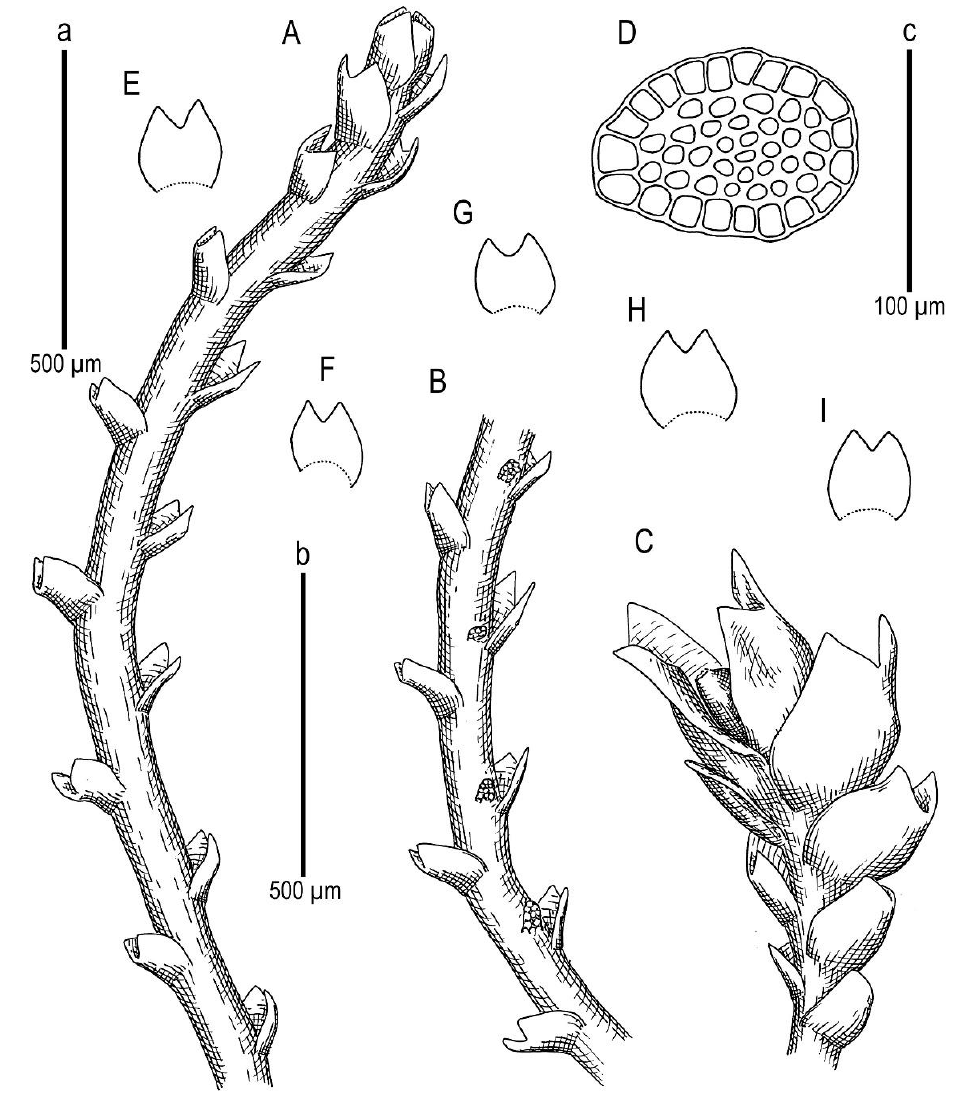
Figure 7. Marsupella taiwanica Mamontov, Vilnet et Schäf.-Verw. sp. nov. : ( A ) shoot, fragment, dorsal view; ( B ) shoot, fragment, ventral view; ( C ) perianthous shoot, fragment; ( D ) stem cross-section; ( E – I ) leaves. Scale: a, b—500 µm ( A – C , E – I ); c—100 µm ( B ). All from Holotype Schäfer-Verwimp 37,663 (MHA).